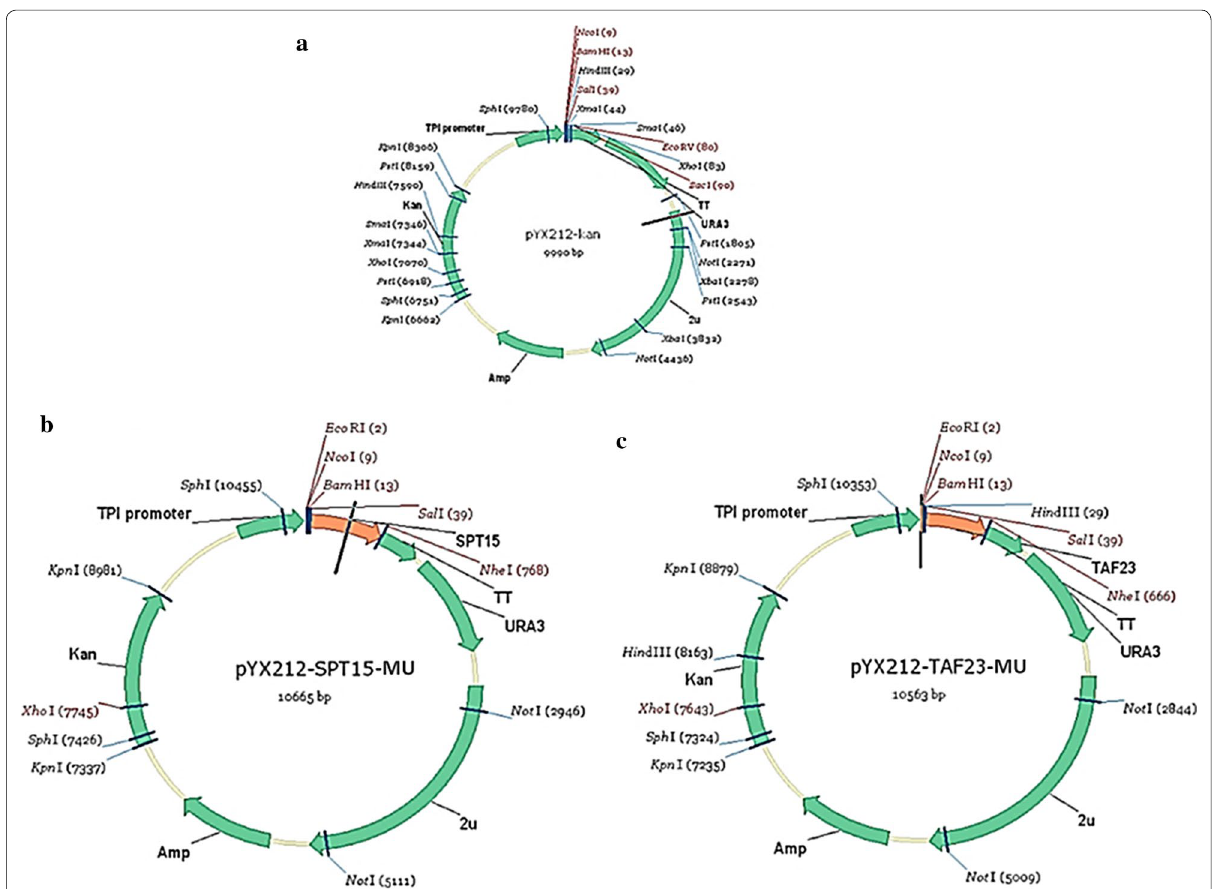
Fig. 1 The physical maps of recombinant plasmids. a The pYX212‑kan (empty vector). b , c The pYX212 with SPT15 ‑ Mu and TAF23 ‑ Mu , respectively. The genes are under the R‑control of TPI promoter and terminator with Eco RI and Sal I restriction sites for SPT15 and Sal I and Nhe I restriction sites for TAF23 ; (Amp r ) ampicillin resistance gene; (Kan r ) Kanamycin resistance gene; (G418) resistance